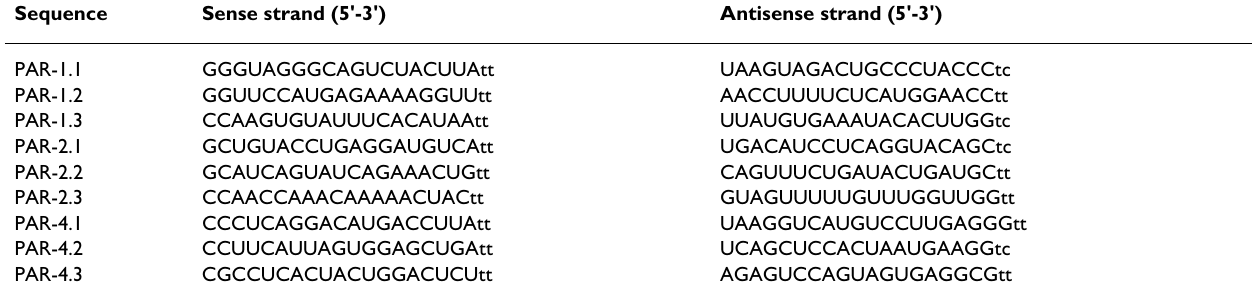
Table 1: siRNA sequences of PARs